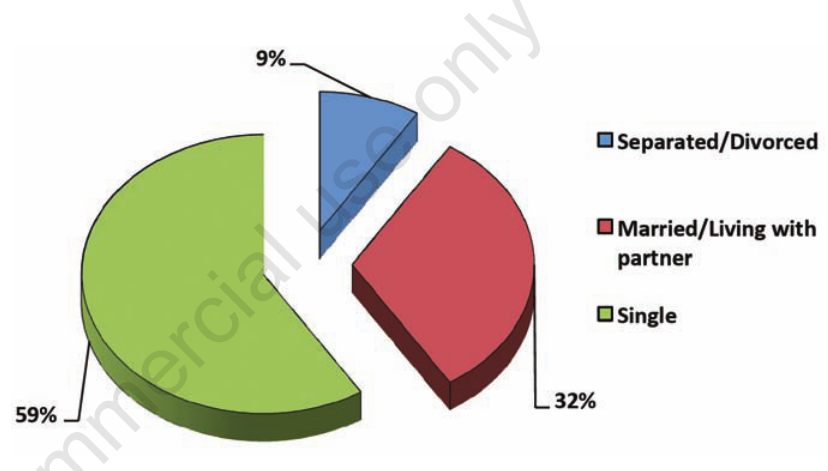
Figure 1. Marital status of the patients interviewed (%).